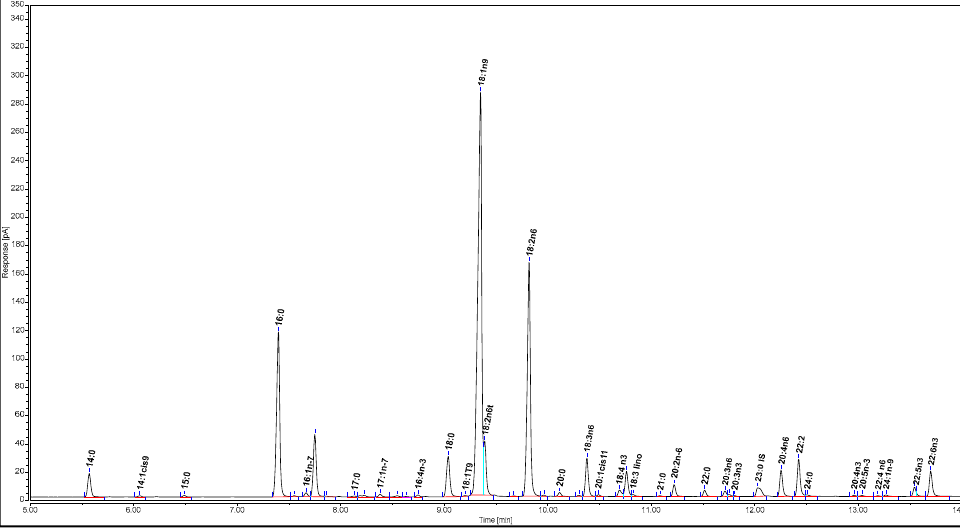
Figure 2. Gas chromatogram of Atlantic salmon oil.